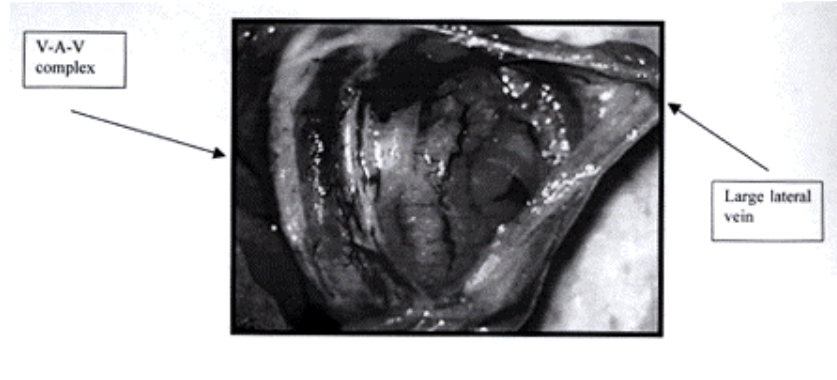
FIGURE 3 . Varicocele vascular pattern.